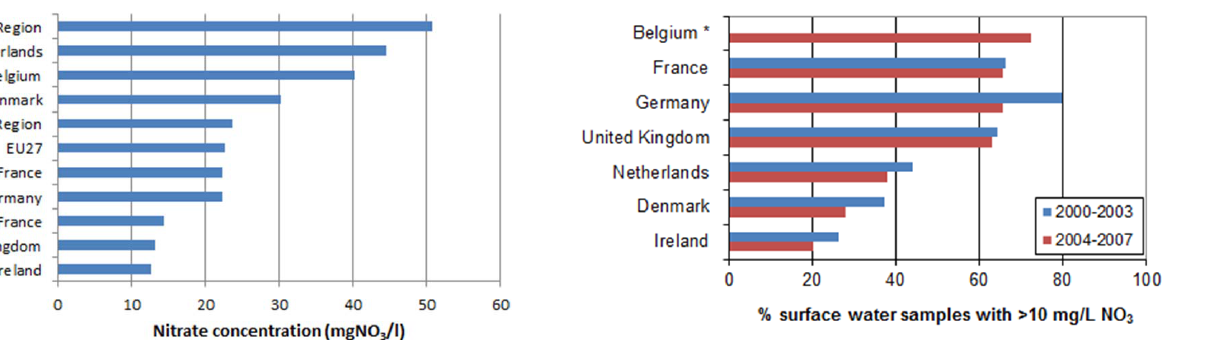
Fig. 6. Mean nitrate concentration (UAA and precipitation surplus Figure 6. Mean nitrate concentration (UAA and precipitation surplus weighted) in leaching 2 weighted) in leaching water from agricultural soils in northwestern water from agricultural soils in northwestern EU in 2008 by MITERRA model. 3 EU in 2008 by MITERRA model.